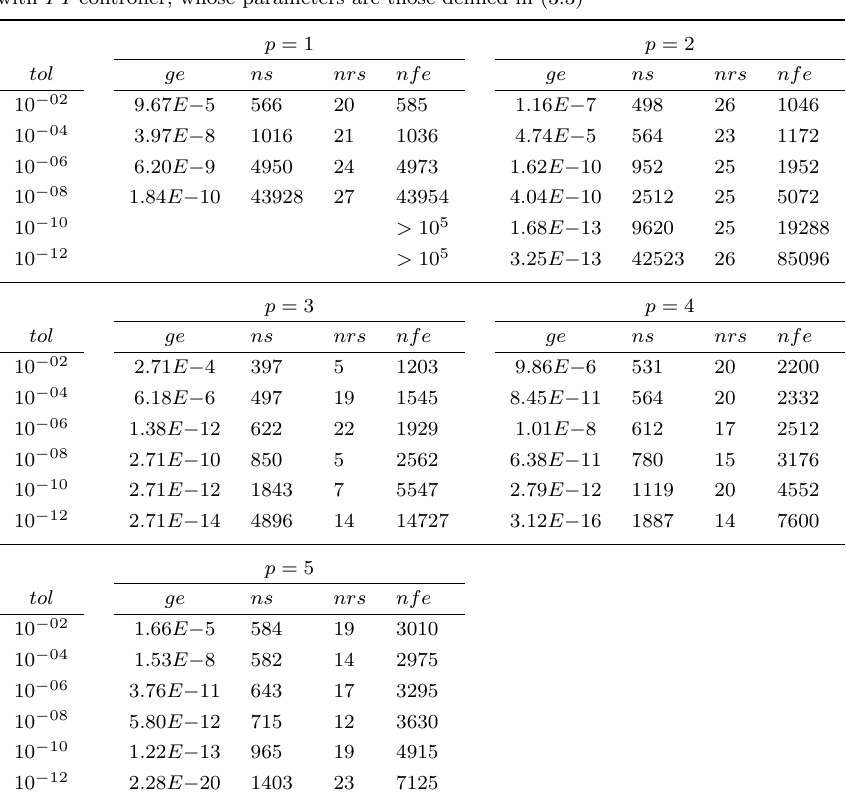
Table 4. Results of numerical experiments for Prothero-Robinson problem (4.2) with PI controller, whose parameters are those defined in (3.3) p =